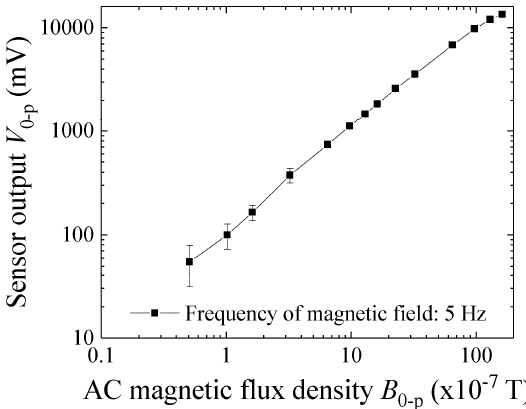
Figure 12. Variation of the sensor output as a function of AC magnetic flux density at 5 Hz.